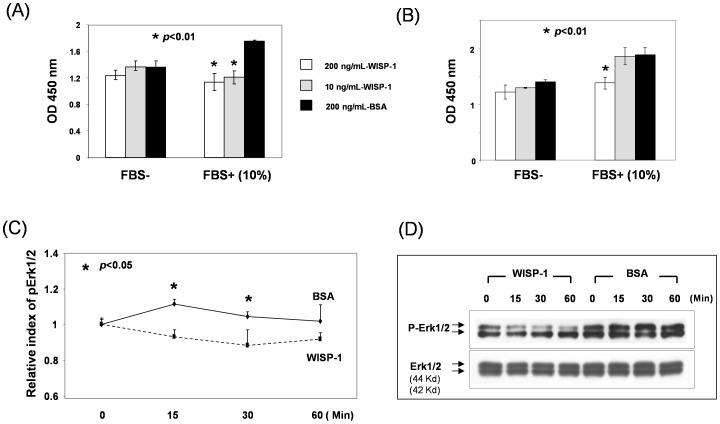
Effect of WISP-1/CCN4 on cell growth of fibroblasts.Supplementation of exogenous recombinant human WISP-1/CCN4 slowed down cell growth of FF2441 cells (A) and Cre/MEFs (B). Proliferation of cells was determined by MTT assays. 5,000 FF2441 cells/well and 2,000 Cre/MEFs/well were plated respectively. Data are presented as mean ± SD of three independently performed experiments. (C) Addition of 200 ng/mL of recombinant human WISP-1/CCN4 inhibited serum-induced phosphorylation of Erk1/2 in FF2441 cells. Total amount of Erk1/2 was used as control. Time course of phosphorylation of Erk1/2. Serum starved cells were stimulated with 10% serum in the presence of WISP-1/CCN4 for varying times. Autophotographs of Western blots were quantified by computerized densitometry. pERK1/2 signals were normalized to total ERK levels and unstimulated (time “0”) samples were set as “1”. Relative index of pErk1/2 compared to unstimulated samples from three independent Western blots was plotted. (D) A representative Western blot was shown.